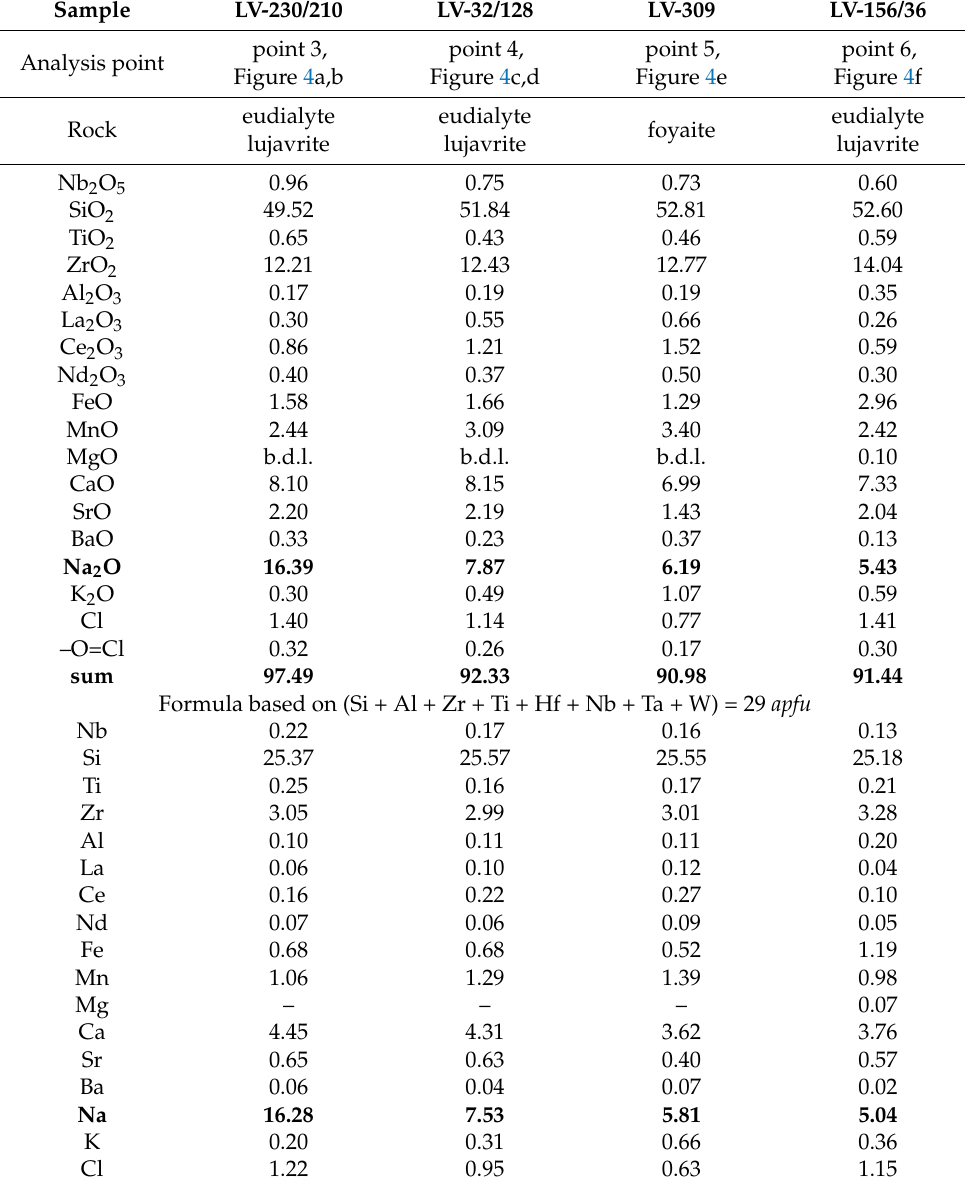
Table 3. Representative chemical analyses of partially dissolved EGMs (wt.